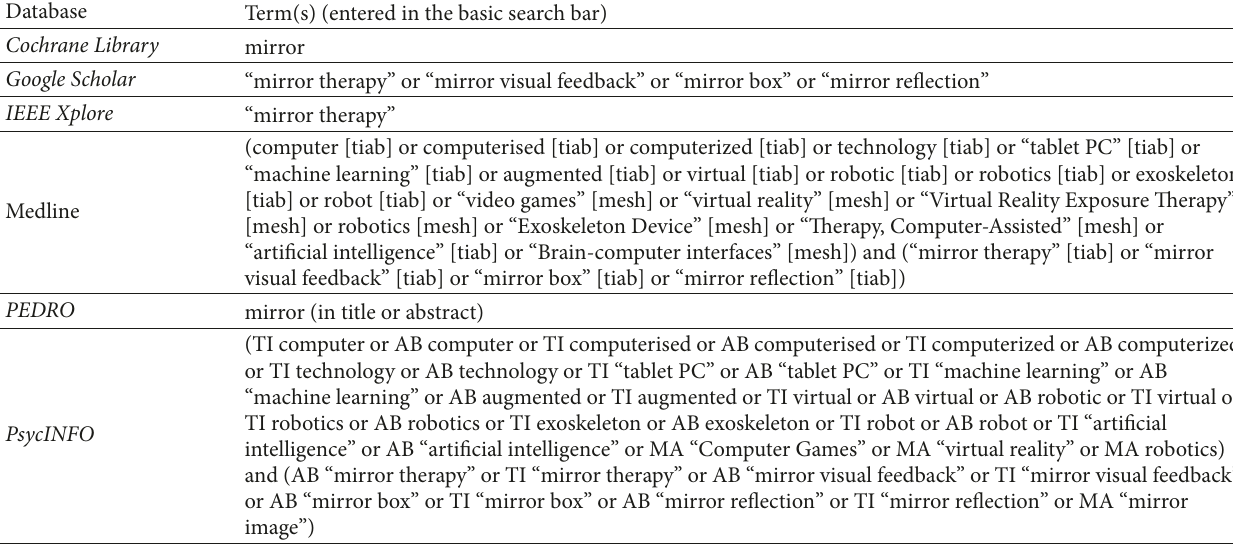
Table 1: Full search